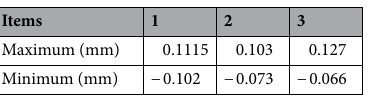
Table 3. Synchronous error under different values of P